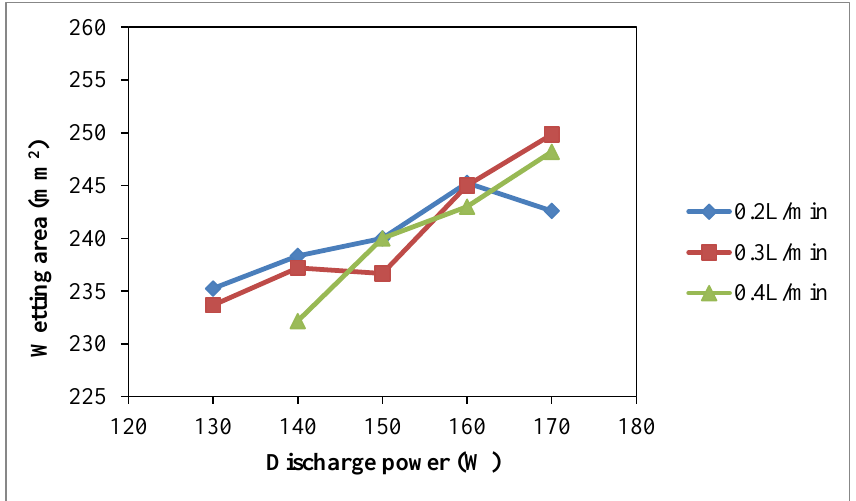
Figure 5. Effect of discharge power on wetting area (Discharge power: 130 W, 140 W, 150 W, 160 W and 170 W; Oxygen flow rate: 0.2 L/min, 0.3 L/min and 0.4 L/min; Jet travelling speed: 5 mm/s and Jet-to-substrate distance: 3 mm).